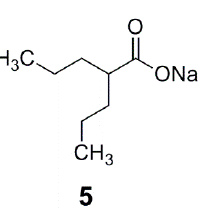
Figure 3. Sodium valproate VPNa 5 , an antiepileptic agent.